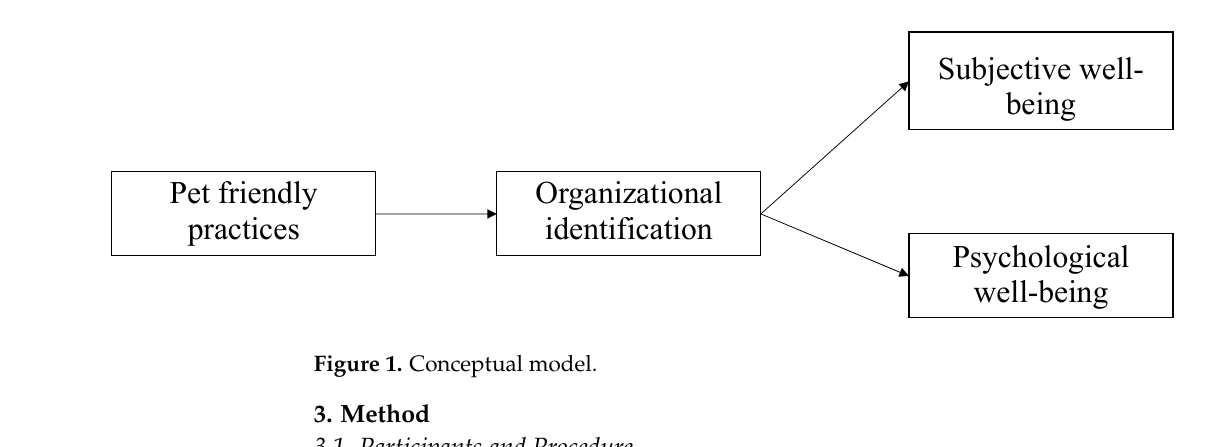
Figure 1. Conceptual model.